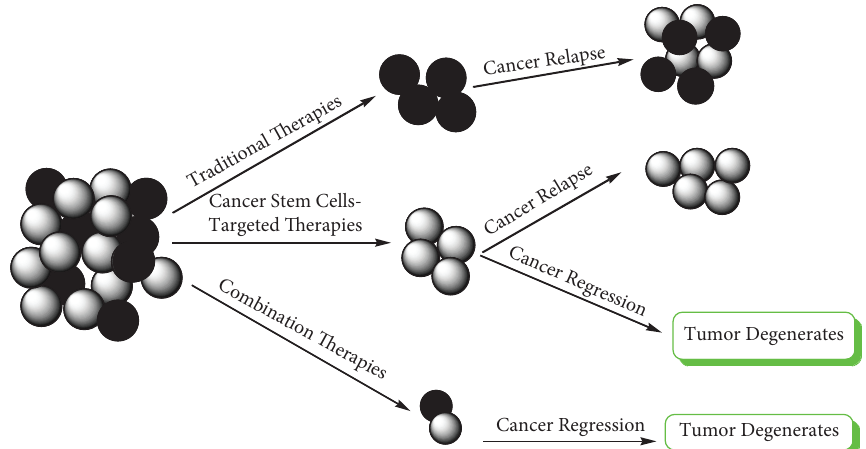
Figure 12: Comparison of the efectiveness of traditional monotherapies and combination